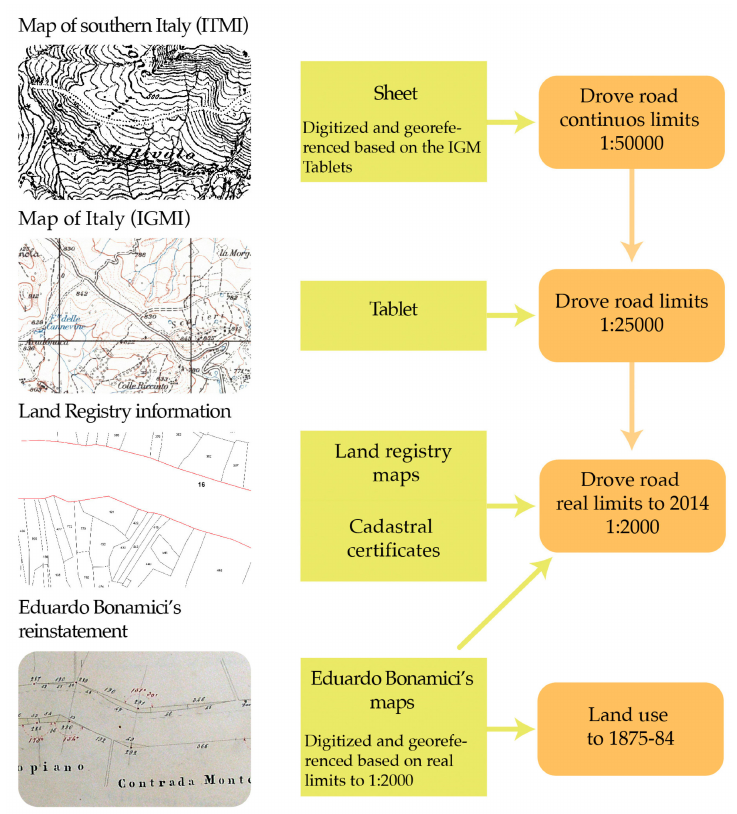
Figure 3. Schematic representation of the methodology used.